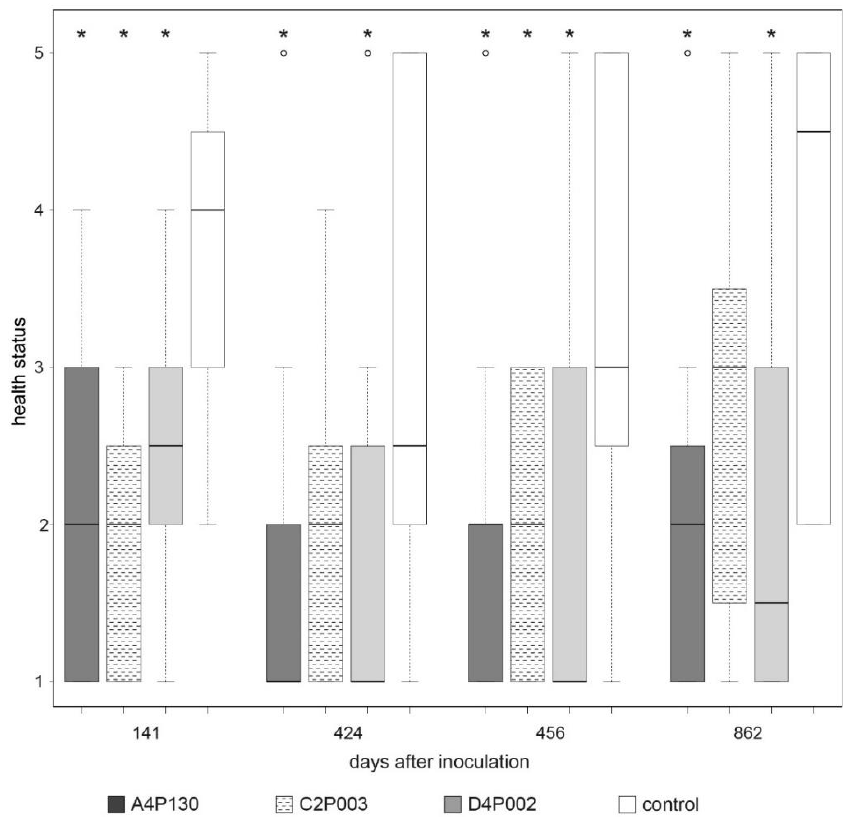
Figure 4. Impacts of inoculation with A. altamirensis C2P003, B. velezensis A4P130 and L. fraxinea D4P002 on ash seedlings. The effects on ash dieback were monitored by the health status of H. fraxineus -infected seedlings. Health status and ash dieback symptoms were estimated as described by Peters et al. [80]. Bonitur scale: 1: healthy, 2: 10–25% leaf damage, 3: 26–60% leaf damage, 4: 61-99 leaf damage, 5: dead plants. Stars indicate significant differences compared to the control ( p < 0.05).